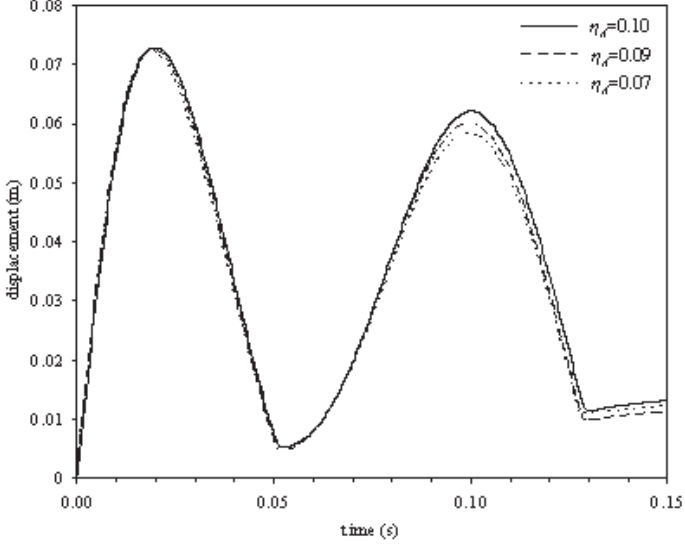
Fig. 14. Comparison of the displacement of m 1 using a 41 DOF residual diffusion FE-FCT mesh with, η A = 0.10, η A = 0.09, and η A = 0.07 (note all cases use η D =